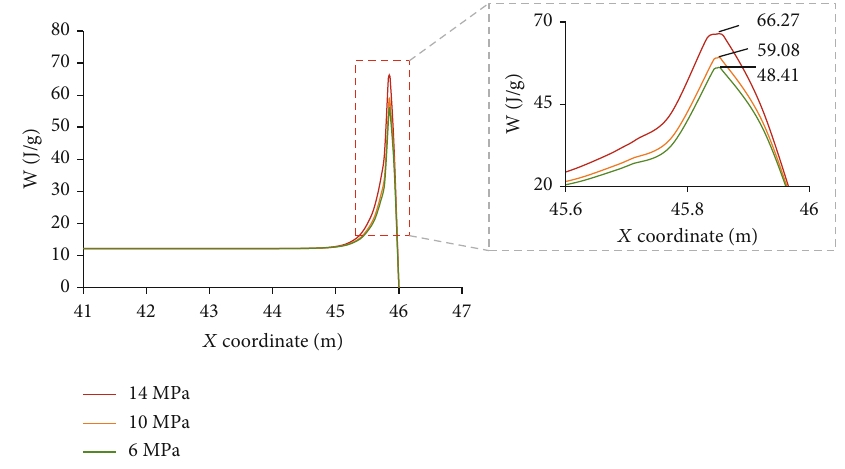
Figure 7: Expansion energy of gas under di ff erent